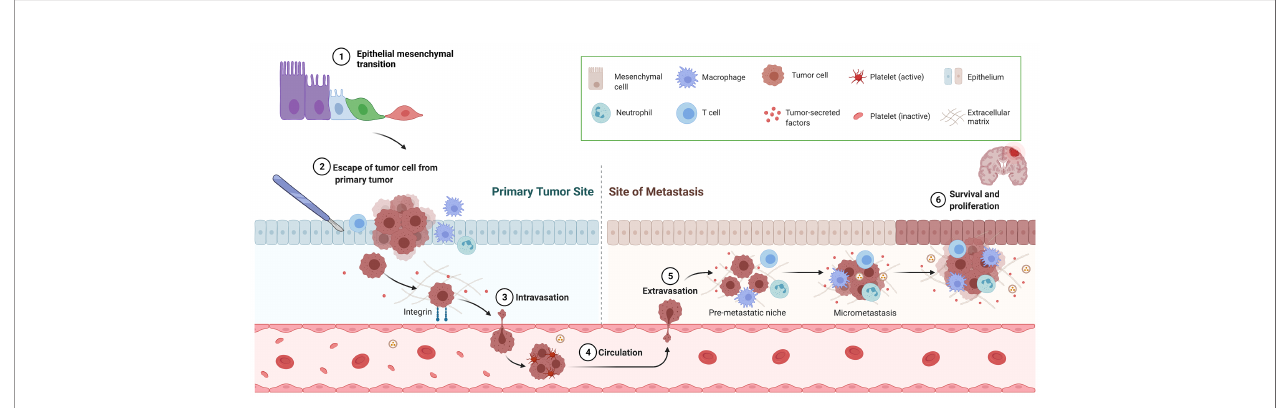
FIGURE 1 | Overview of metastatic cascade. This fi gure represents the necessary steps for successful metastasis including epithelial-mesenchymal transition, escape of tumor cell from primary tumor, intravasation, circulation, extravasation and survival and